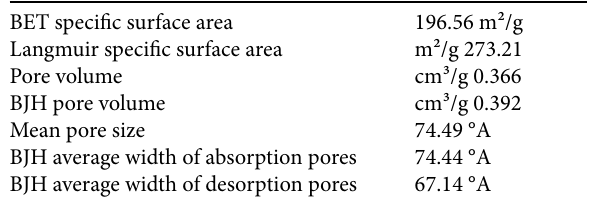
Table 1. Surface features of MnFe 2 O 4 nanoparticles by BET analysis BET specific surface